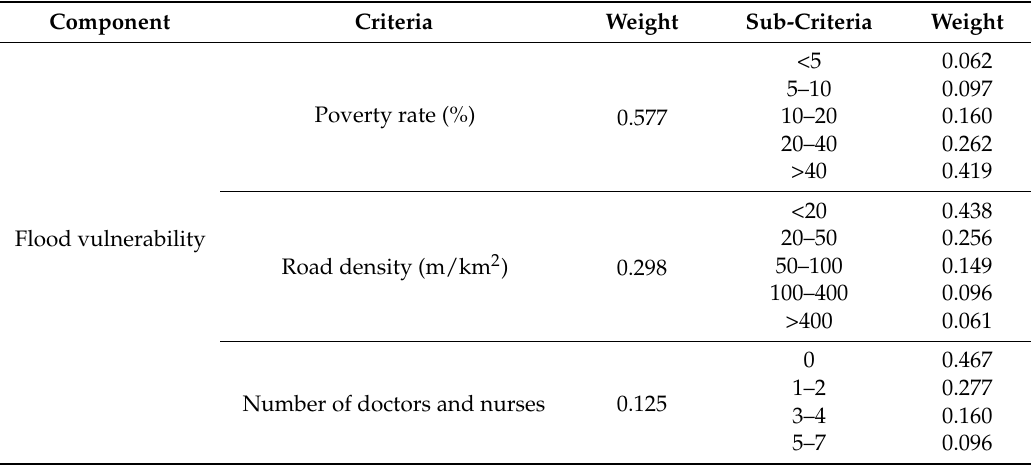
Figure 6. Distribution of flood vulnerability criteria and sub-criteria. Table 3. Decision hierarchy model for flood vulnerability